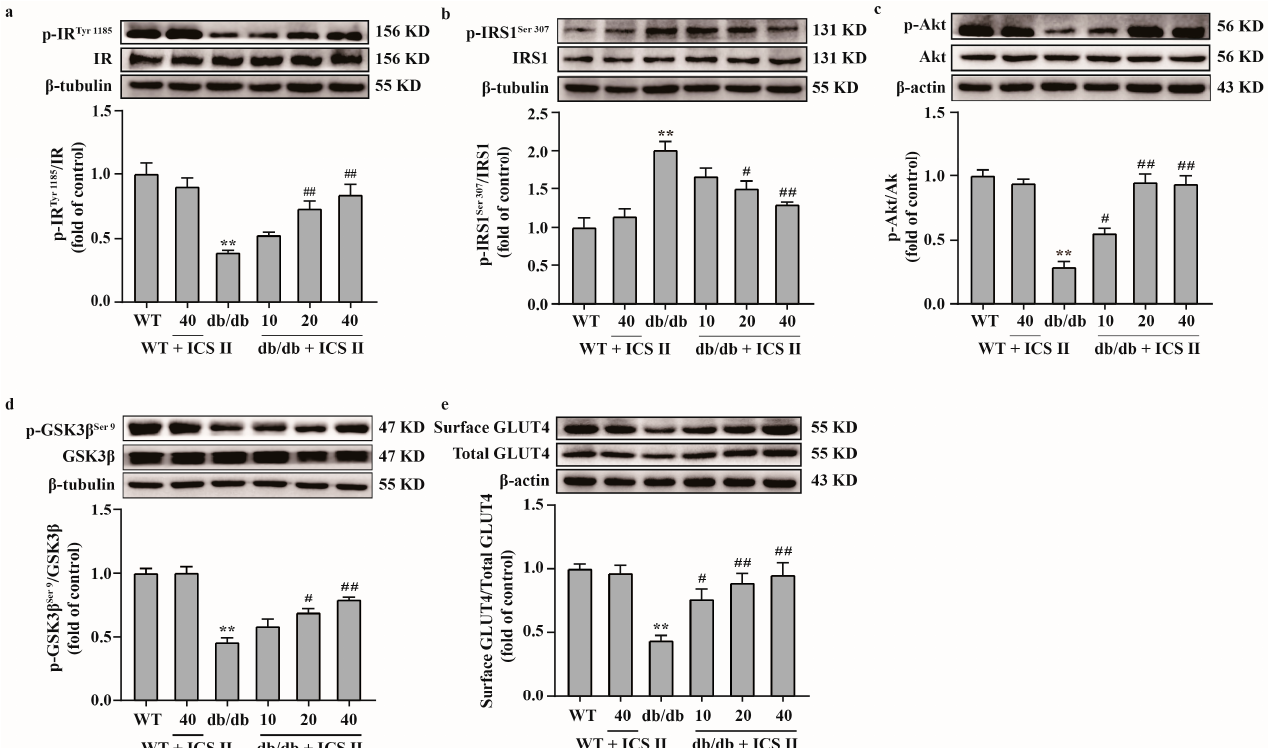
Figure 6. ICS II attenuated insulin resistance in db/db mice by regulating the IRS1/Akt signaling transduction pathway. ( a ) Representative western blot of phosphorylation level of IR Tyr 1185 and quantitation of phosphorylation level of IR Tyr 1185 in the liver ( n = 5). ( b ) Representative western blot of phosphorylation level of IRS1 Ser 307 and quantitation of phosphorylation level of IRS1 Ser 307 in the liver ( n = 5). ( c ) Representative western blot of phosphorylation level of Akt and quantitation of phosphorylation level of Akt in the liver ( n = 5). ( d ) Representative western blot of phosphorylation level of GSK3 β Ser 9 and quantitation of phosphorylation level of GSK3 β Ser 9 in the liver ( n = 5). ( e ) Representative western blot of cell surface and total GLUT4, and quantitation of cell surface GLUT4 content in the liver ( n = 5). Data were expressed as mean ± SEM. ** p < 0.01 versus WT group; # p < 0.05 and ## p < 0.01 versus db/db group.